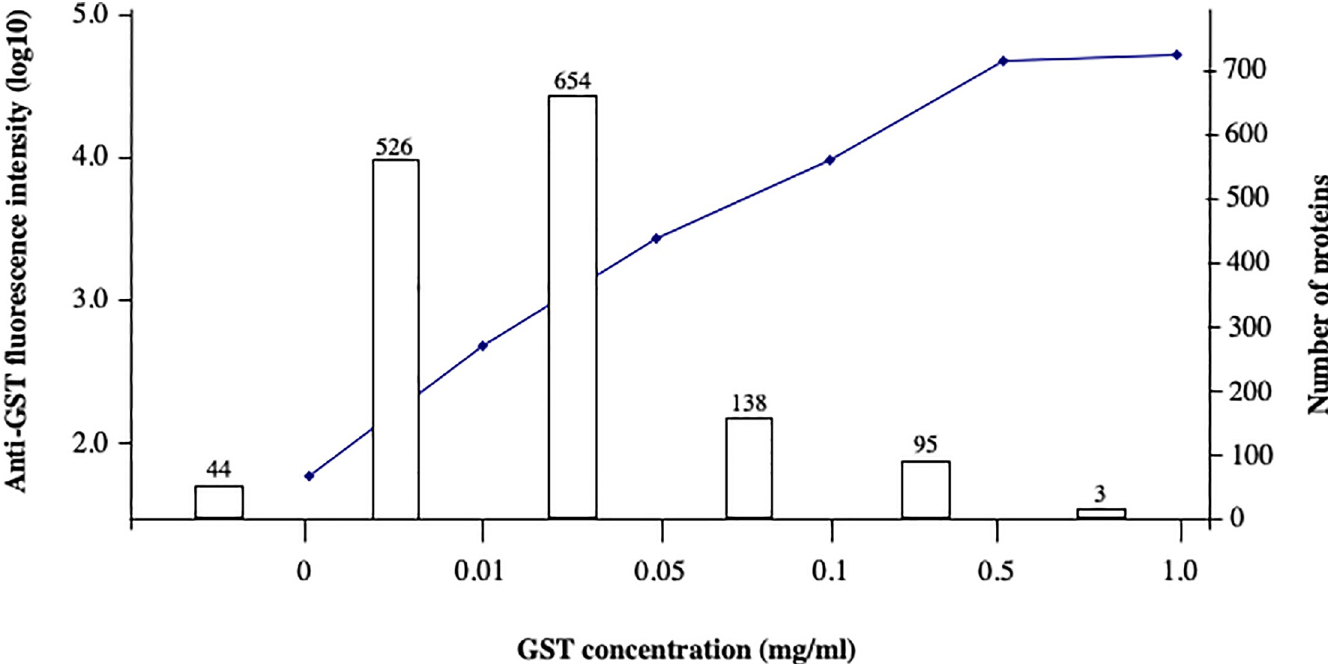
Fig 2. Arrayed protein concentrations. The curve depicts anti-GST fluorescence intensities (log10, left Y axis) for GST standards at the indicated concentrations (X axis); “0” GST corresponds to spots with no added protein (“Empty” in Fig 3). Bars depict the number of C . jejuni proteins with anti-GST fluorescence intensities corresponding to each range of GST